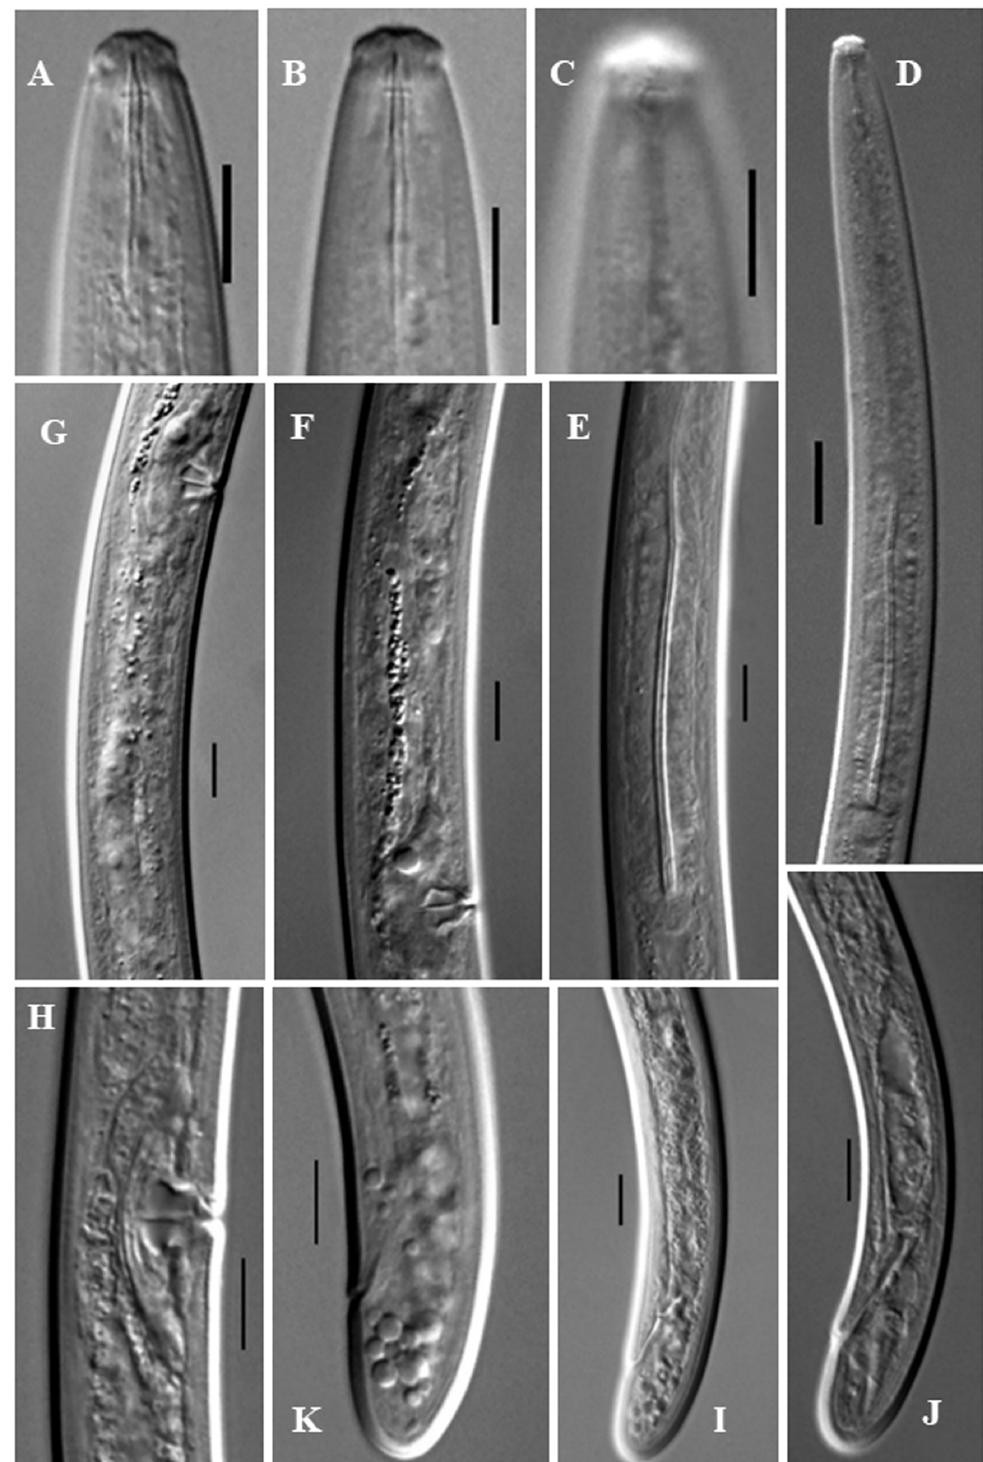
Fig. 6. Tylencholaimus cosmos (Dhanam & Jairajpuri, 1999), ♀ (LM photographs). A–B . Anterior region. C . Anterior region showing amphid. D . Pharyngeal region. E . Expanded part of pharynx. F–G . Genital system. H . Vulval region. I–J . Posterior region. K . Posterior end. Scale bars: A–C, E–K = 10 μm; D = 20